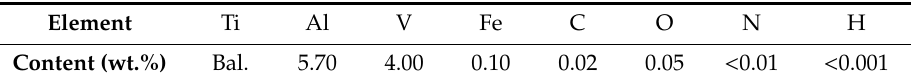
Table 1. Chemical composition of the Ti6Al4V titanium alloy.